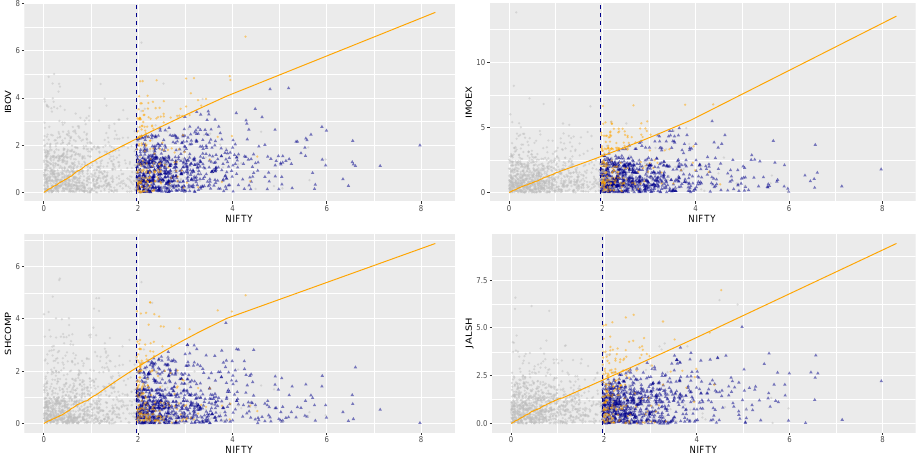
Figure 9. Prediction plot conditioning on NIFTY being above its 90th percentile.